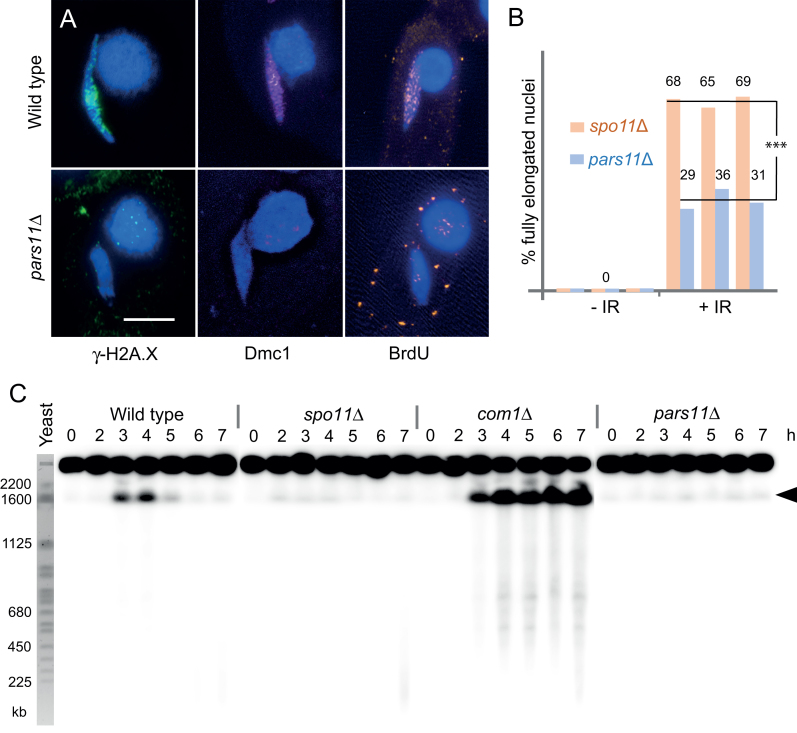
DSBs are not formed in pars11Δ. (A) Markers of DSB formation, sensing and repair. Histone variant H2A.X is phosphorylated (γ-H2A.X), Dmc1 localizes to chromatin and BrdU is incorporated into meiotic nuclei in the WT but not pars11Δ. Bar: 5 μm. (B) Nuclear elongation is partially but differently (***P < 0.001, t-test) restored in spo11Δ and pars11Δ by γ-radiation (IR)-induced DNA damage. Three biological repeats with 100 cells each for spo11Δ and pars11Δ were evaluated. (C) DSBs are visualized by PFGE. DSB-dependent DNA fragmentation is transient in the WT and permanent in the com1Δ mutant. Most DSB-dependent DNA fragments migrate as a single band (arrowhead). Only slight chromosome fragmentation (possibly due to DNA damage during sample preparation) is seen in spo11Δ and pars11Δ. Budding yeast chromosomes are shown as size markers. h: hours after induction of meiosis.